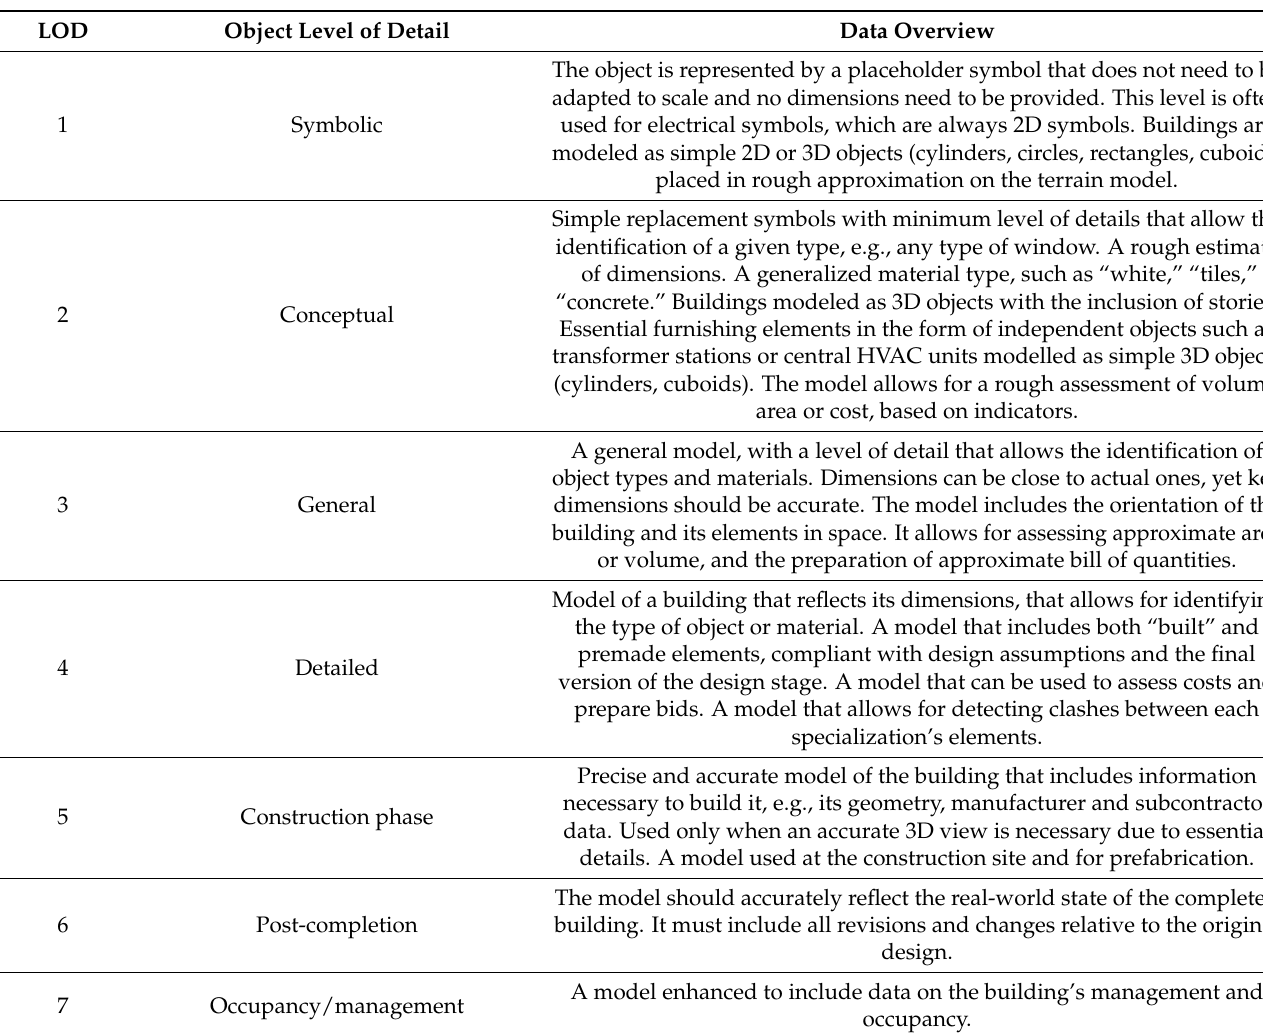
Table A1. Level of detail definitions from the EIR appendices for the Lesser Poland Science Center and the Krakow Music Center, formulated based on British